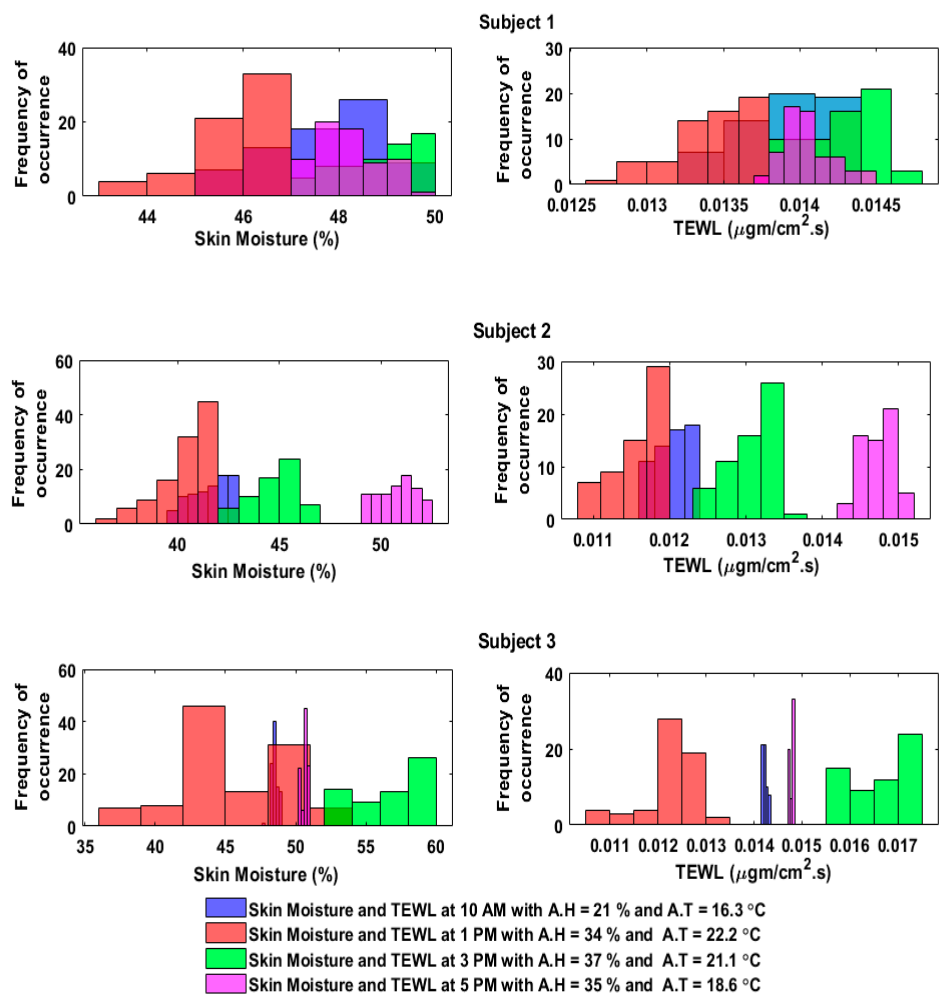
Figure 10. Histogram relationship between the skin moisture and the TEWL in the outdoor environment.